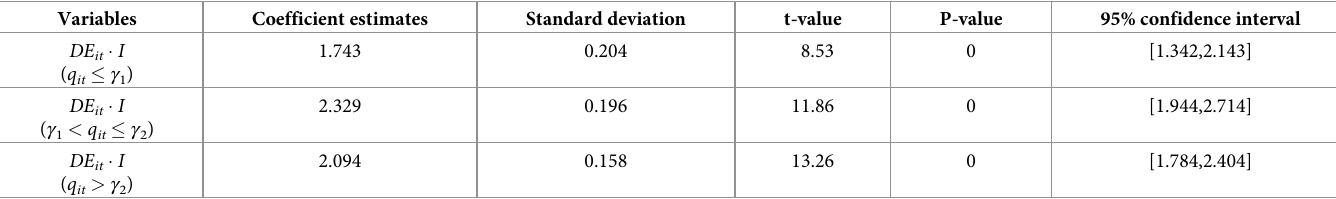
Table 6. Threshold panel model regression